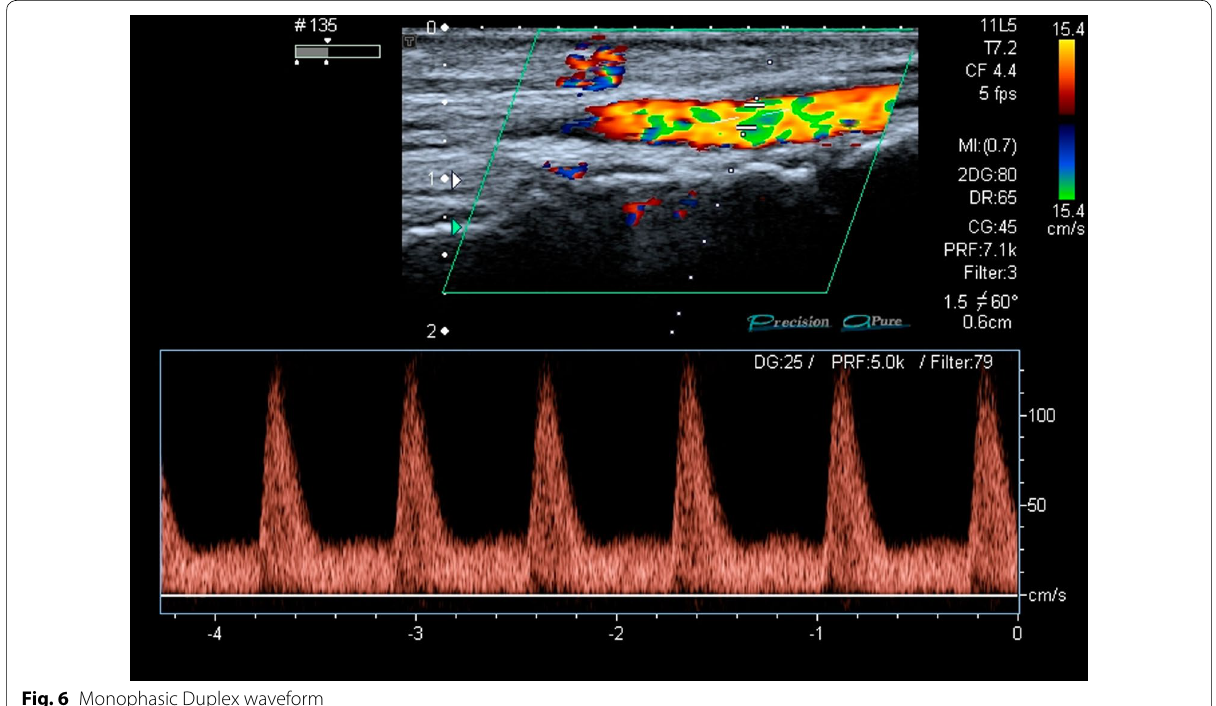
Fig. 6 Monophasic Duplex waveform